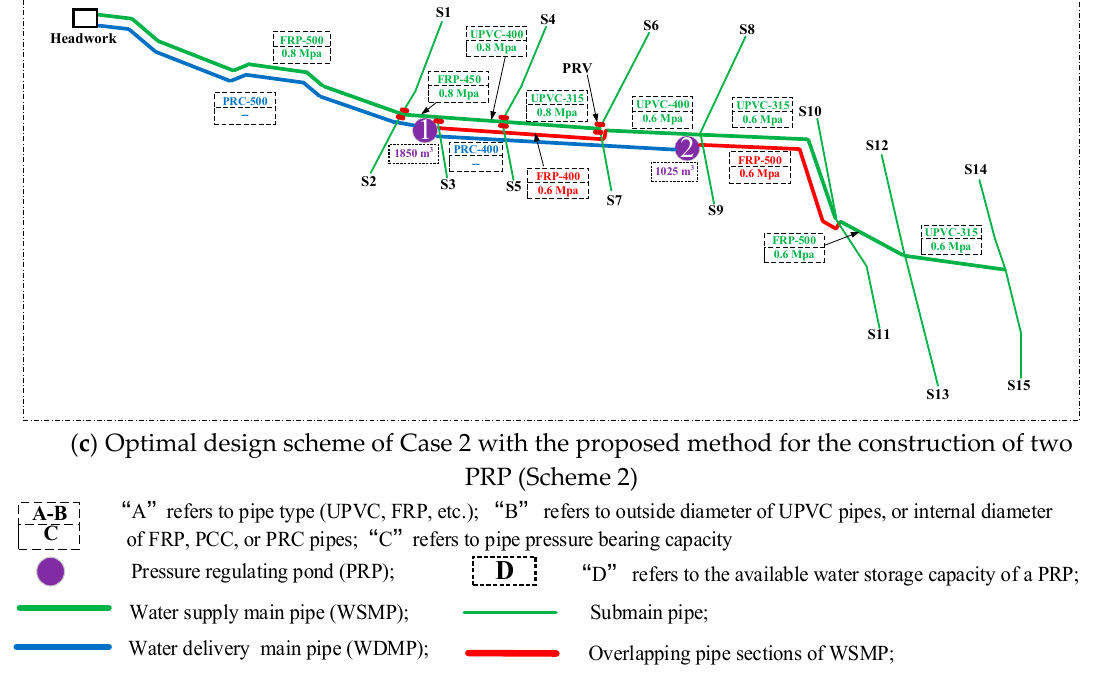
Figure 6. Design schemes with the ( a ) empirical method and ( b , c ) proposed methods for Case 2.